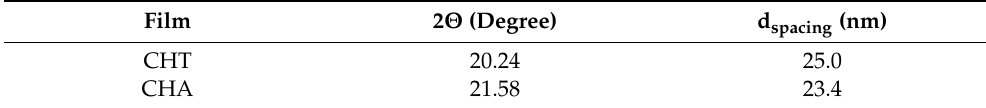
Figure 7. X-ray diffraction of CH films. Table 3. 2θ angle and d -spacing of chañar films bands. Film